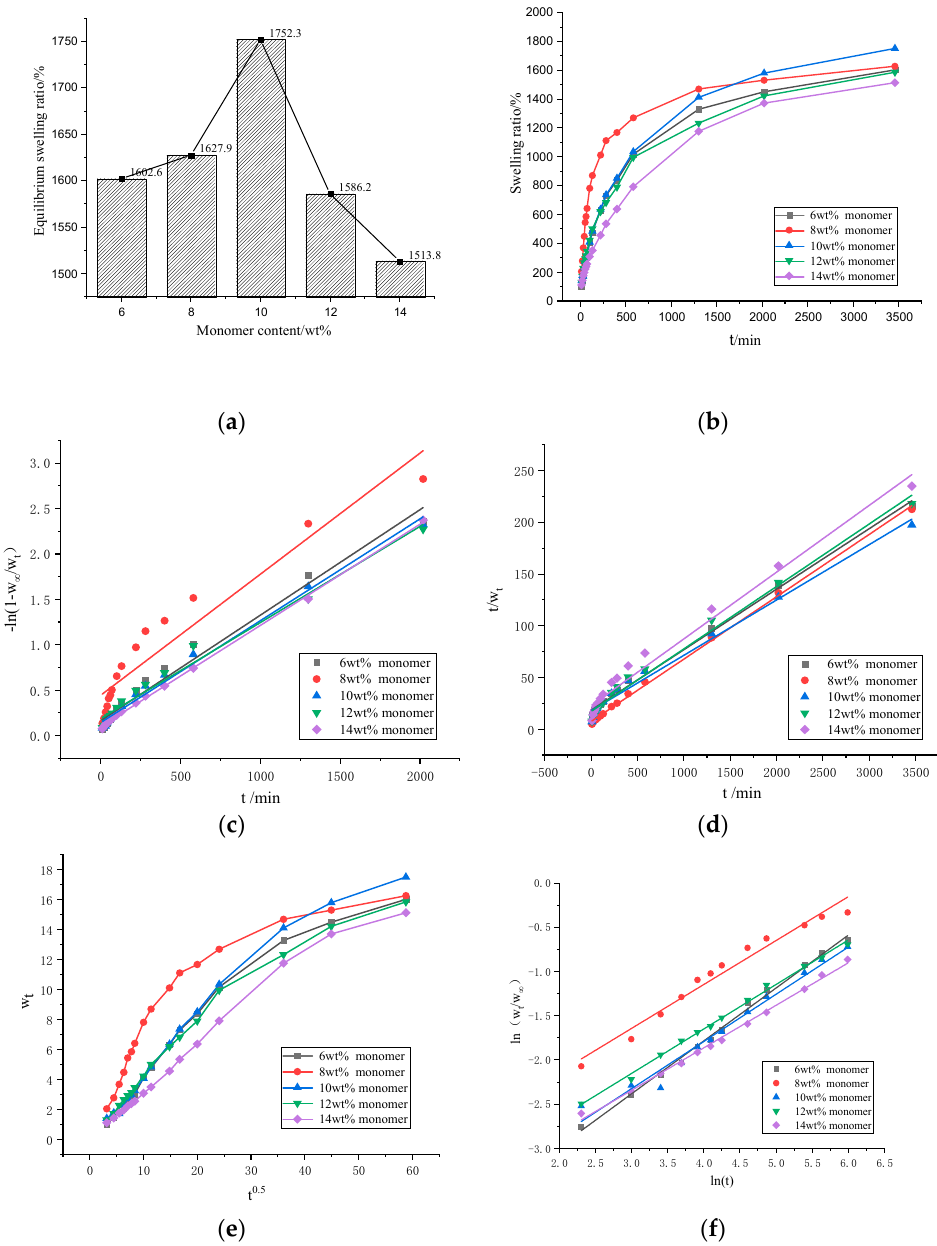
Figure 5. ( a ) The equilibrium swelling ratios of the GA–P(NIPAM-co-DMAPMA) hydrogels with different monomer contents. ( b ) Swelling kinetics curves of the hydrogels with different monomer contents. ( c ) Swelling kinetics of the hydrogels with different monomer contents fitted with the first-order kinetic equation. ( d ) Swelling kinetics of the hydrogels with different monomer contents fitted with the second-order kinetic equation. ( e ) Relationships between the swelling rate and t 0.5 of hydrogel with different monomer concentration ( f ) (ln (W t /W ∞ )–lnt diagram) of the hydrogels with different monomer contents.